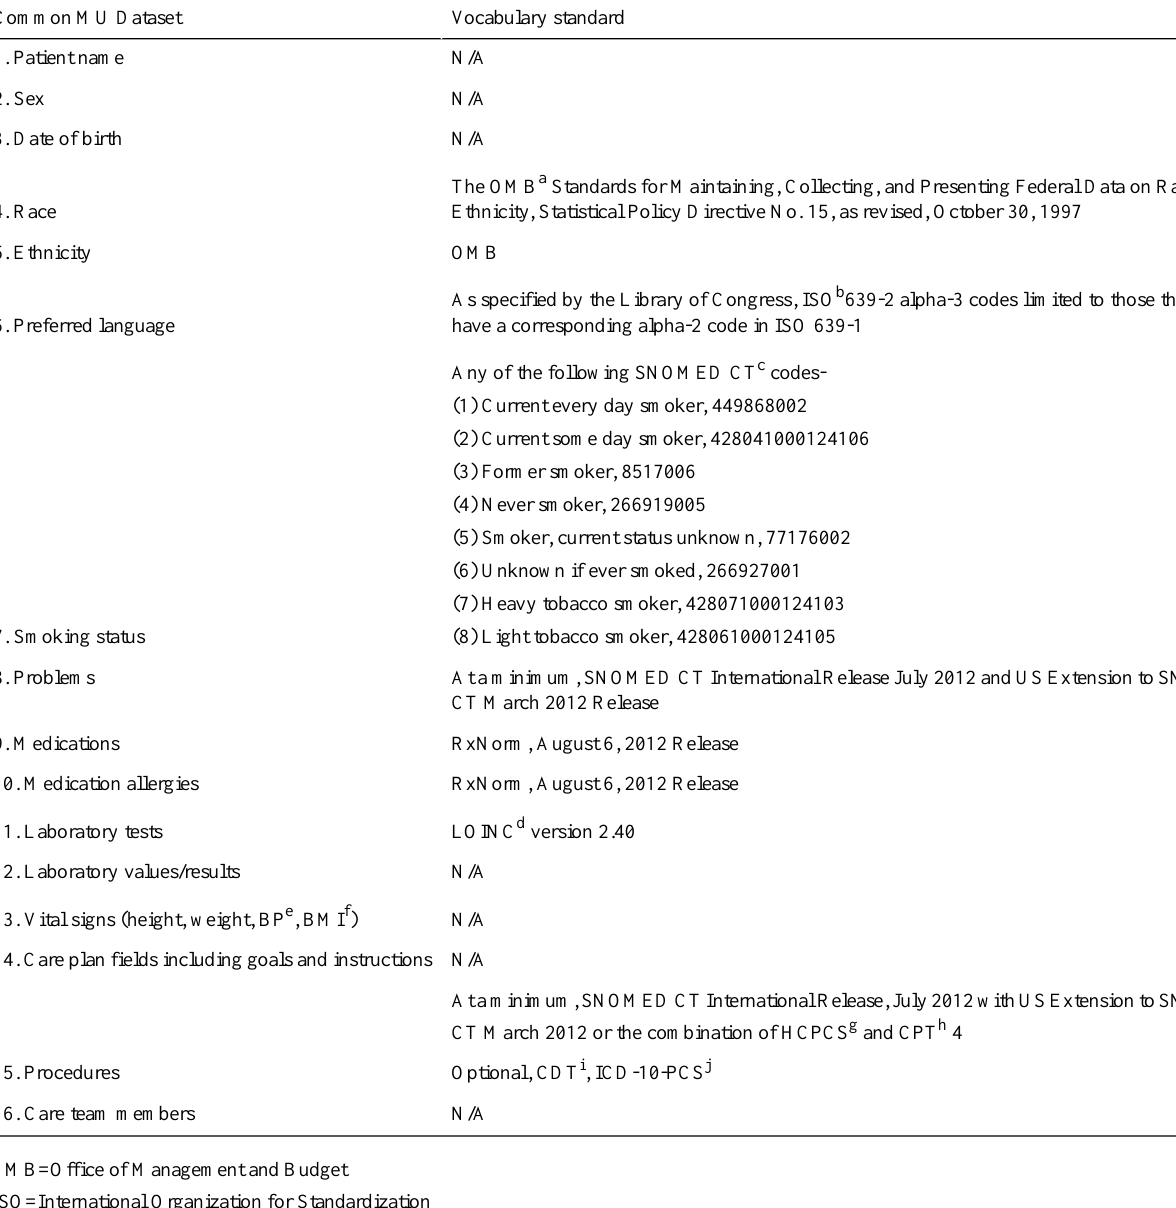
Table 1. Common MU Dataset defined in Stage 2 MU Final Rule (Federal Register Vol. 77, No. 171, September 4, 2012) and corresponding vocabulary